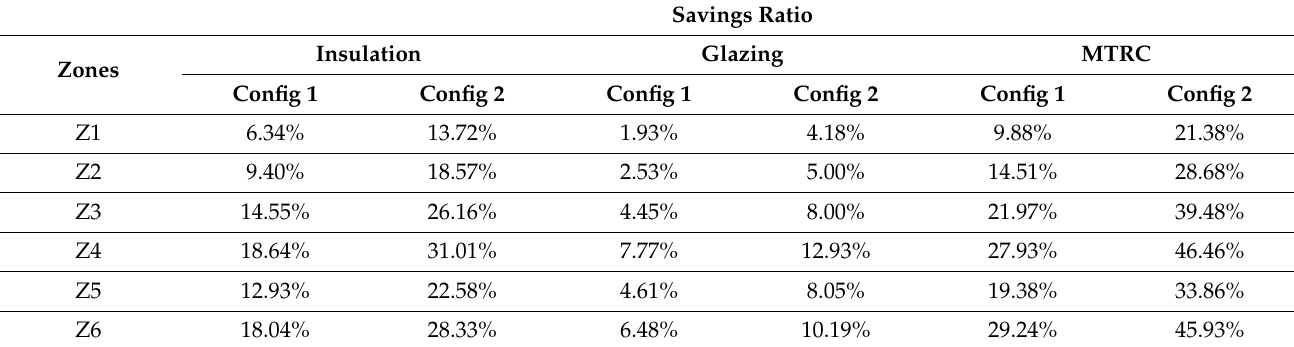
Table 19. Savings using the passive system SWH (on total energy building). Savings